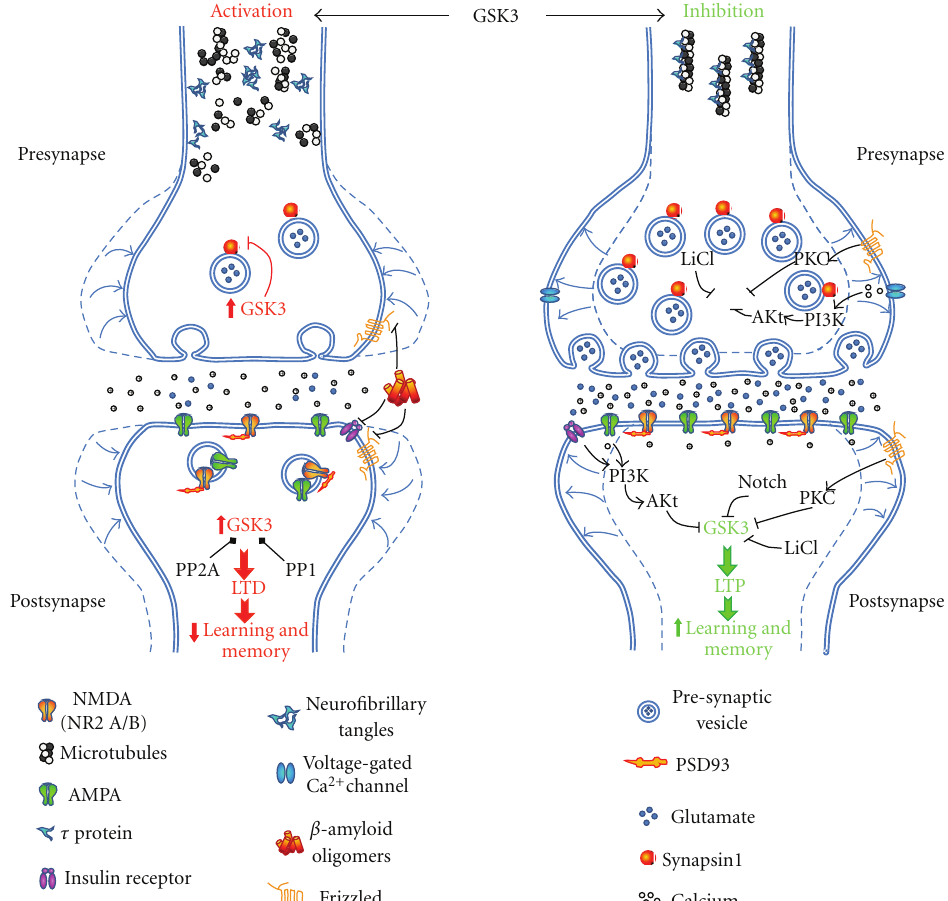
Figure 3: Schematic representation of pre- and postsynaptic mechanisms involved in neuronal plasticity and the role of GSK3. In the presynapse GSK3 activity decreases the expression of SynI reducing the release of glutamate while in postsynapses GSK3 transiently activates NMDA receptors leading to endocytosis of AMPA receptors and reduces the levels of PSD93 protein, favoring LTD. In contrast, Wnt and PI3K signaling pathways or pharmacological inhibition of GSK3 by LiCl supports the induction of LTP, facilitating learning and memory. GSK3 inhibition is also involved in axon and dendritic widening in both pre- and postsynaptic sites. Serine/threonine phosphatases PP1 and PP2A can activate GSK3 regulating phosphor-GSK3 levels through its dephosphorylation. GSK3 is important in the modulation of multiple signaling pathways including Notch pathway that plays an important role in di ff erent developmental processes. In AD, amyloid- β oligomers inhibit Wnt and insulin signaling pathways leading to activation of GSK3. In addition, GSK3 overactivation mediates τ hyperphosphorylation and microtubule